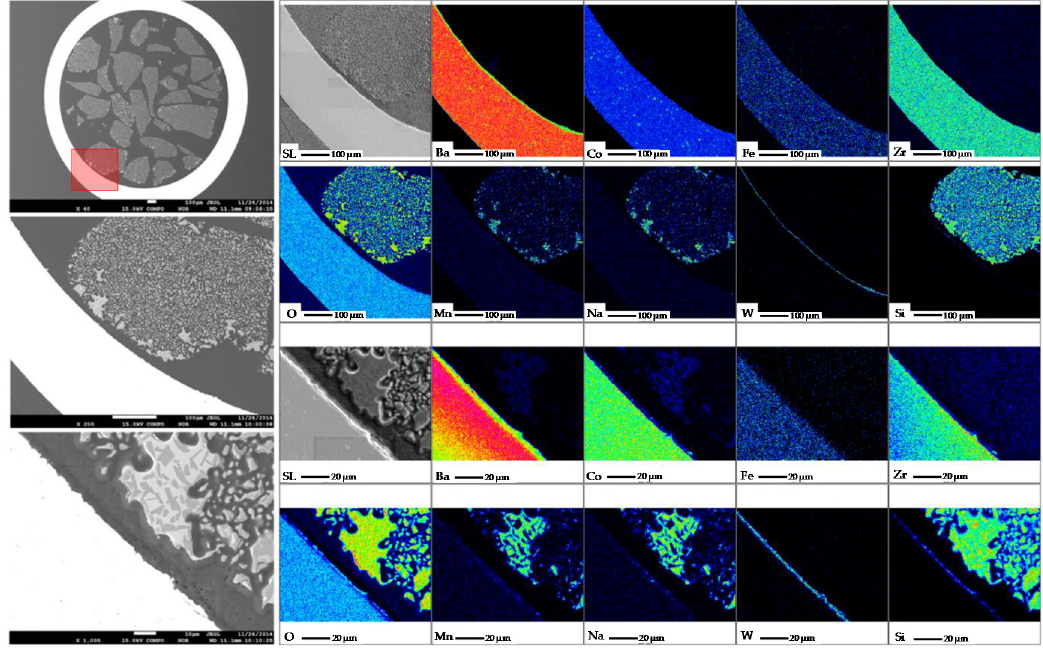
Figure 25. Scanning Electron Microscopy coupled with Wavelength Dispersive X-ray Spectrometry (SEM-WDS) analysis of a cross sectional area of the OCM lab scale reactor used. The red rectangle represents the area covered for the analysis [28].